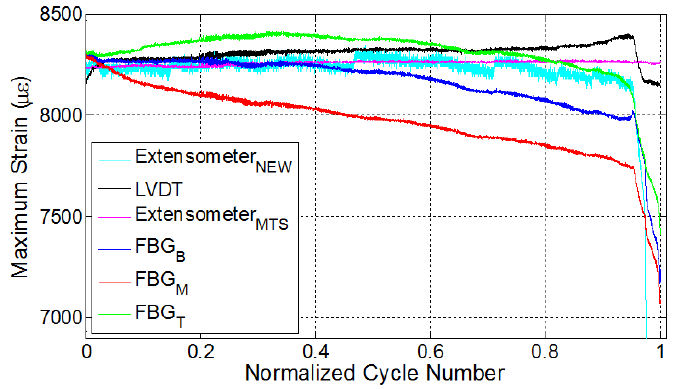
Figure 7. Evolution of strain for specimen